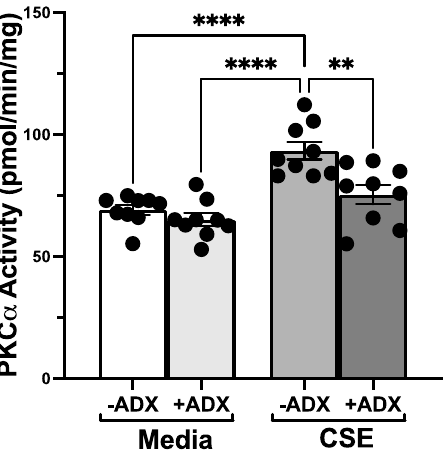
Figure 3. ADX-102 and bronchial epithelial cell protein kinase C alpha (PKC α ) activity. BEAS-2B cells were pretreated with or without 10 µ M ADX-102 for 1 h prior to treatment with M-199 containing 10% serum (Media) or 5% cigarette smoke extract (CSE) for 1 h. In the absence of ADX-102, **** p < 0.0001 CSE vs. Media. In the presence of CSE, ** p < 0.01. No ADX vs. ADX. Bars represent SEM of n = 9, each with three replicates.